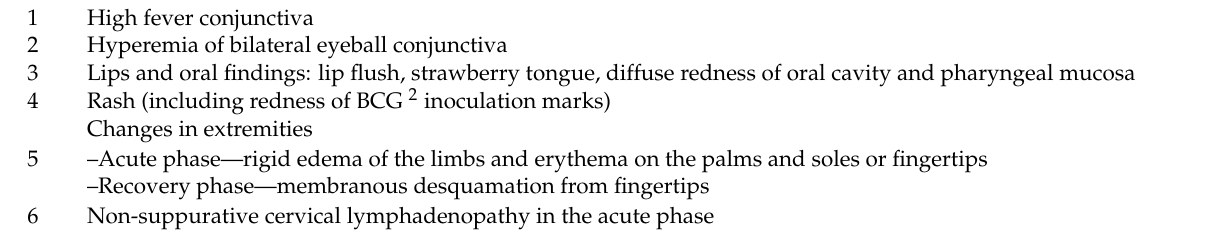
Table 2. Main symptoms in the diagnostic guide of KD 1 (sixth